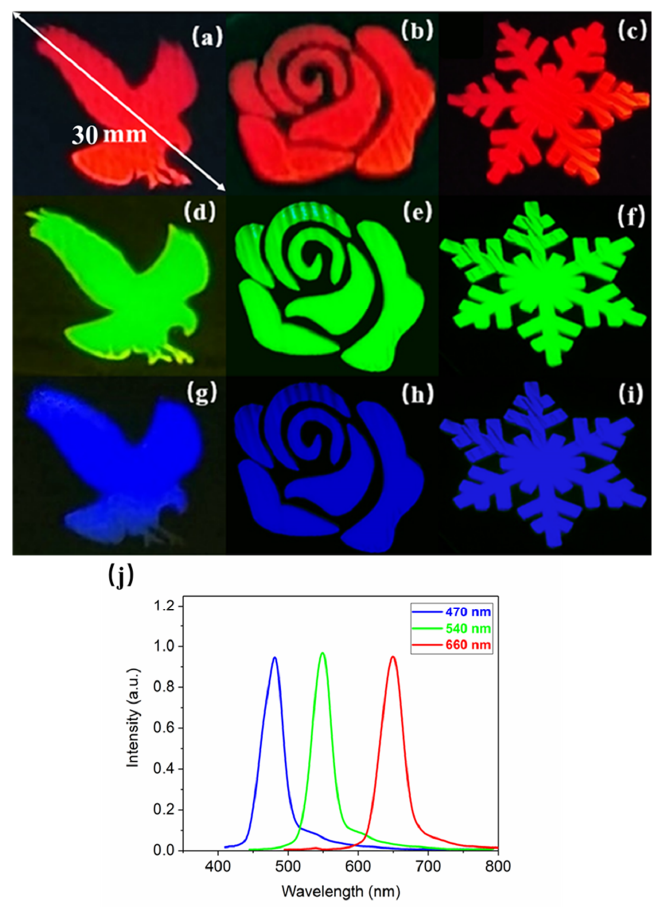
Figure 14. ( a – i ) Optical images, and ( j ) the diffraction spectra of different patterns composed of extremely regular LSFLs. extremely regular